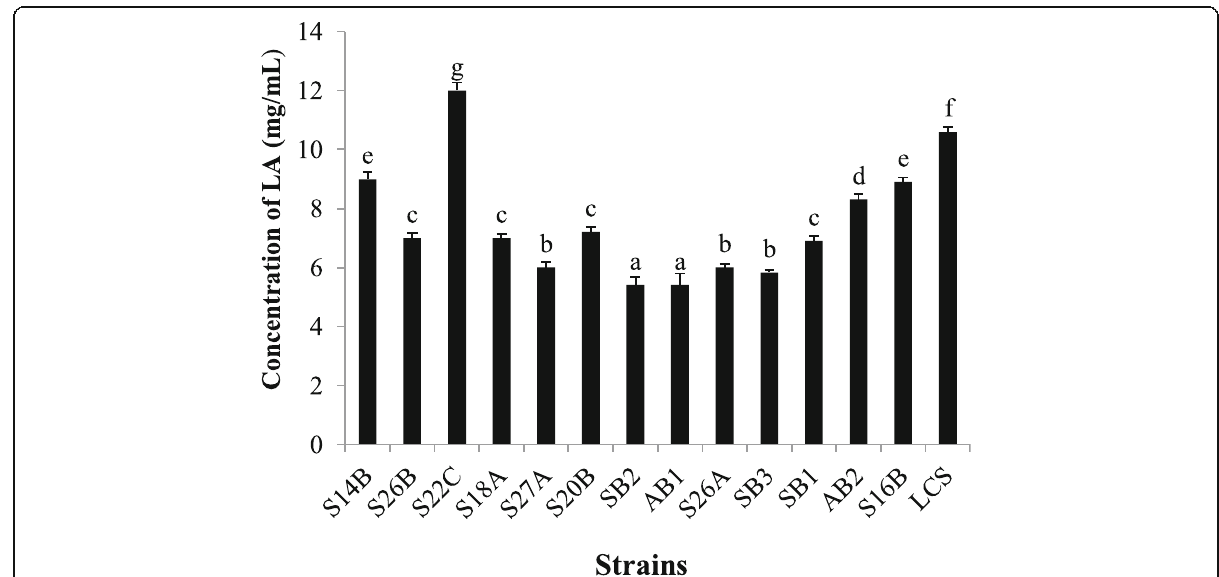
Fig. 3 Quantification of lactic acid produced by Enterococcus strains by titrimetric method. Strain S22C revealed highest production (12 mg/ml) of lactic acid